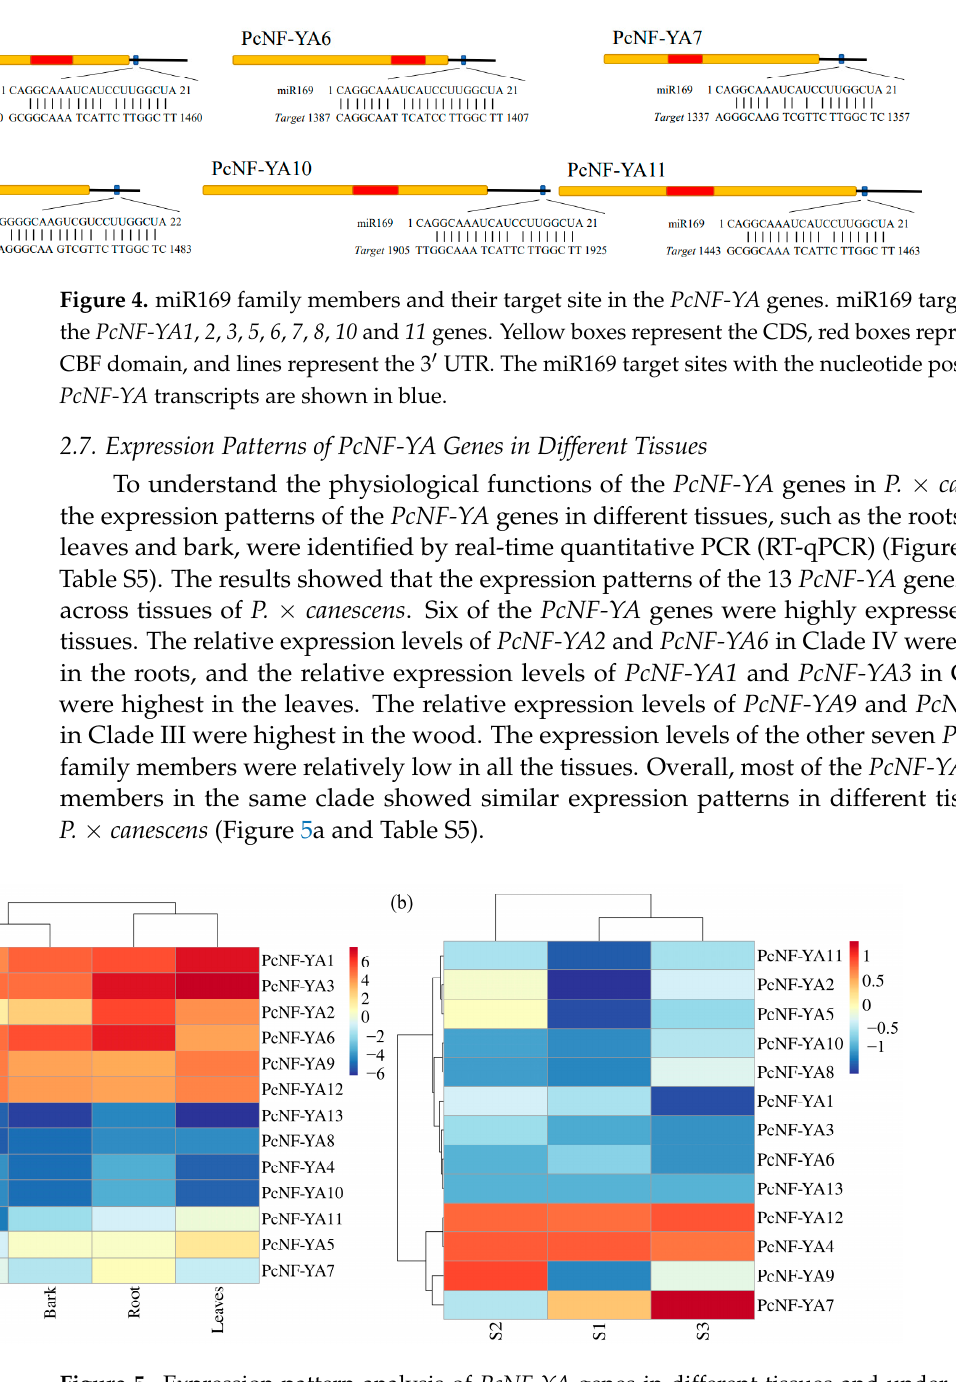
Figure 5. Expression pattern analysis of PcNF-YA genes in different tissues and under different ni- trogen form treatments. ( a ) The expression level of each PcNF-YA in different tissues was compared with the median expression level of all genes, and the log 2 (fold change) in PcNF-YA expression was calculated for heatmap analysis. ( b ) Transcriptome analysis of the PcNF-YA gene expression profile treatment and ammonium treatment,